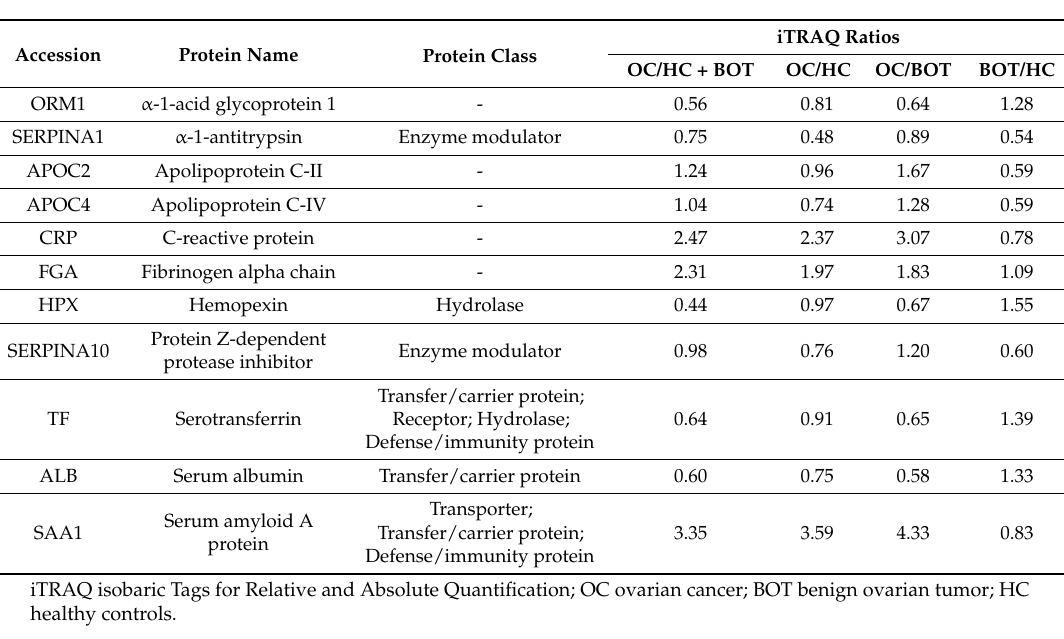
Figure 4. Interaction network of proteins identified as differentially expressed using iTRAQ analysis (source: https://string-db.org): C-reactive protein (CRP), Fibrinogen alpha chain (FGA), Apolipoprotein C-II (APOC2), Apolipoprotein IV (APOC4), Serum amyloid A1 protein (SAA1), Alpha-1-acid glycoprotein 1 (ORM1), Alpha-1-antitrypsin (SERPINA1), Hemopexin (HPX), Serotransferrin (TF), Protein Z-dependent protease inhibitor (SERPINA10) and Serum albumin (ALB).